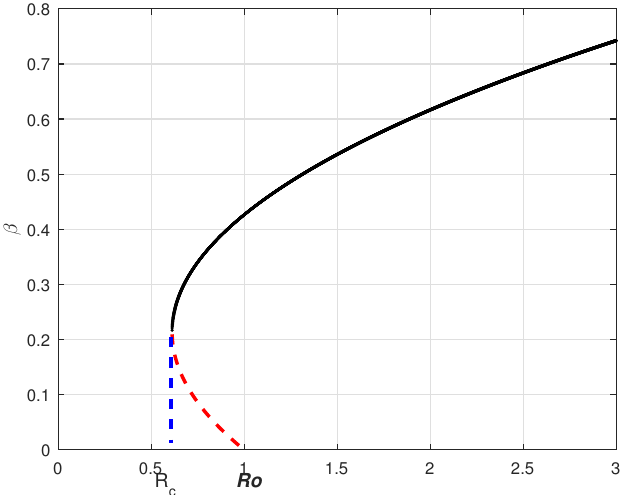
Figure 1. Backward bifurcation graph for the system